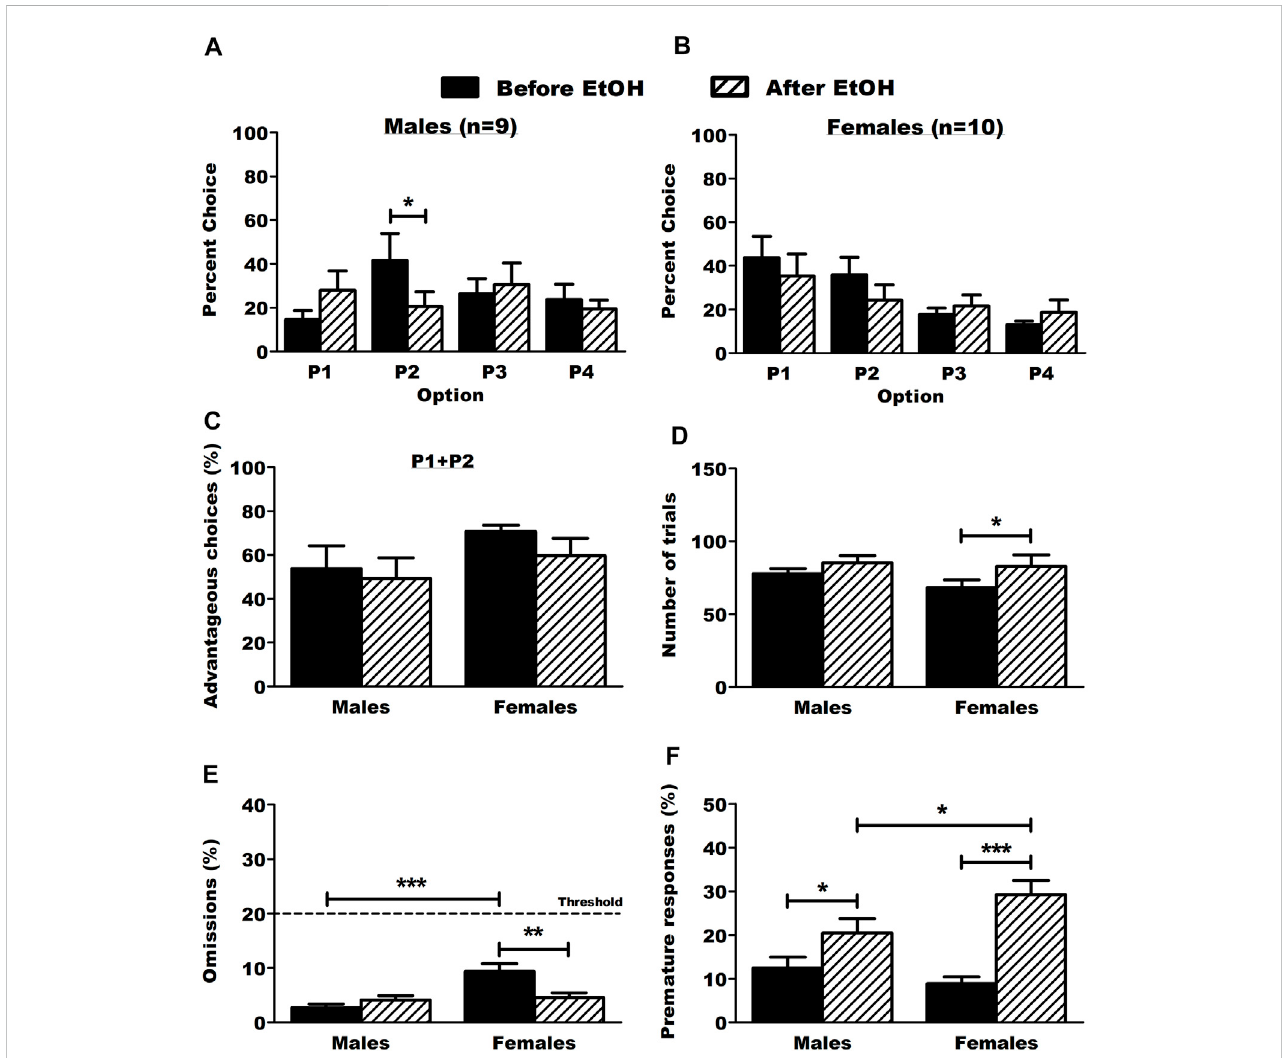
FIGURE 2 Choice behavior and other parameters in the RGT before and after ethanol. (A) Male rats chose the optimal option P2 signi fi cantly less after ethanol. Results are expressed as mean ± SEM of the percent choice of each option. (B) Ethanol did not affect choice behavior in female rats. Results are expressed as mean ± SEM of the percent choice of each option. (C) Ethanol did not affect the proportion of advantageous choices (P1 + P2) in both males and female rats. Results are expressed as mean ± SEM of the proportion of advantageous choices over the total number of choices. (D) Ethanol increased the number of trials in female rats. Results are expressed as mean ± SEM of the total number of trials made. (E) Ethanol decreased omissions in female rats. The dot line represents the threshold of allowed omitted responses for the animals during baseline test sessions. The male rats omitted more trials than the female rats beforeethanol.Results areexpressed asmean±SEMoftheproportionofomittedtrialsoverthetotalnumberoftrials. (F) Ethanolincreased theproportionof prematureresponsesinbothmaleandfemalerats.Thefemaleratsmademoreprematureresponsesthanthemaleratsafterethanol.Resultsareexpressedas mean ± SEM of the proportion of premature responses over the total number of trials. * p < 0.05, ** p < 0.01, *** p <